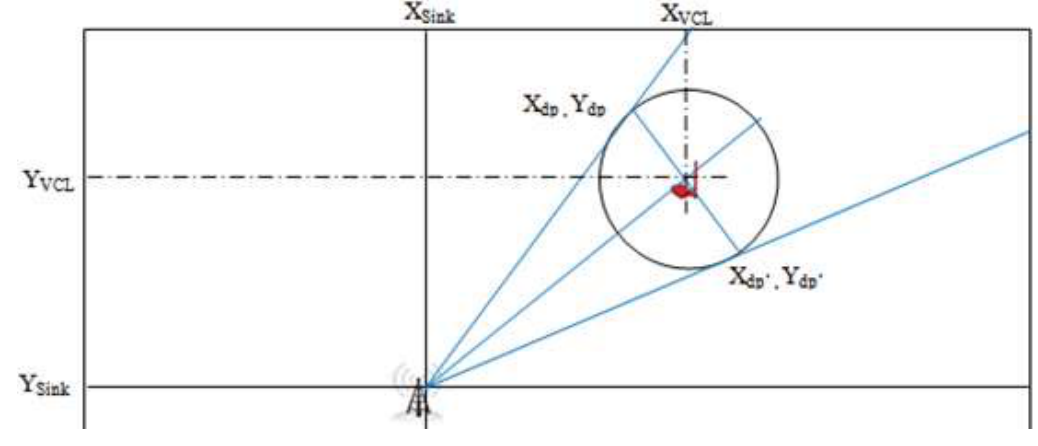
Figure 2. Connecting an intersection point to the sink.